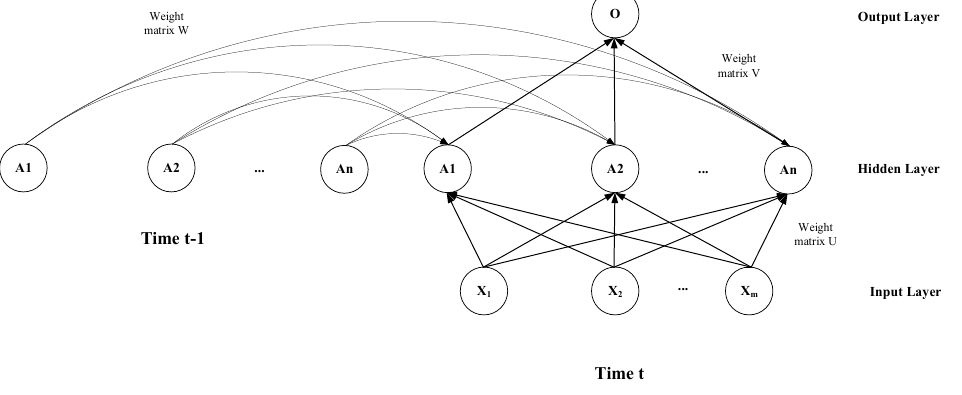
Figure 7. Time series learning model.